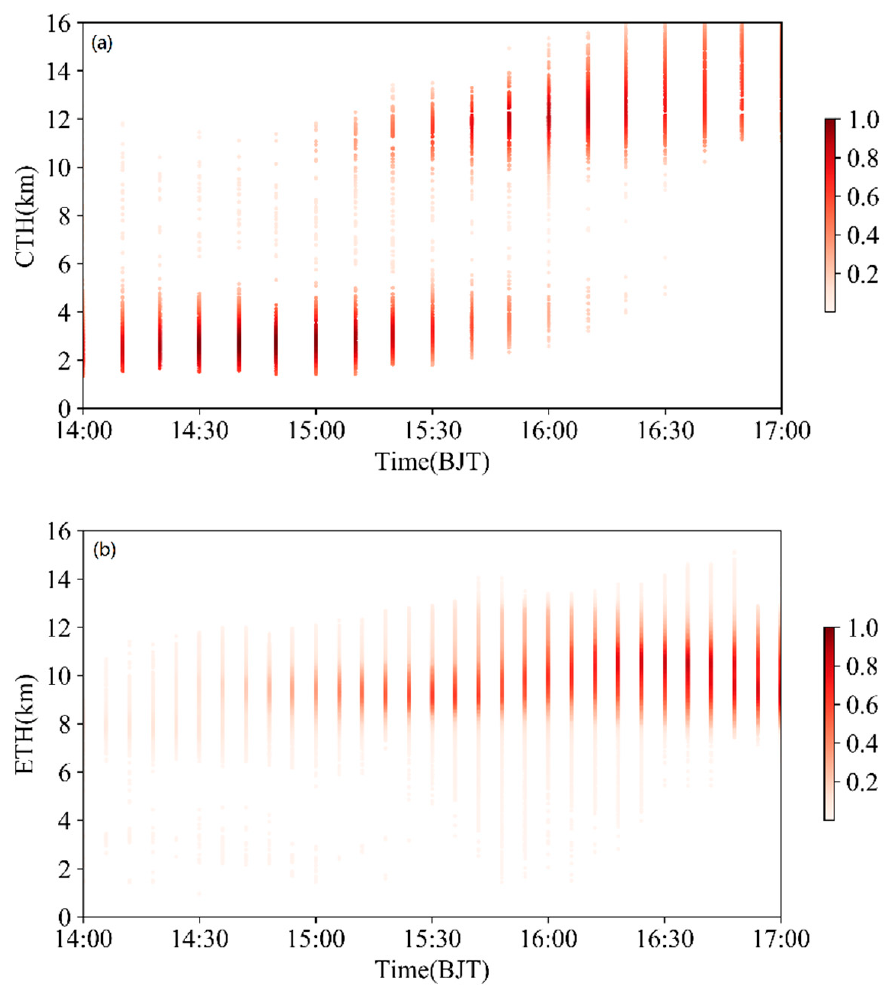
Figure 17. Cloud-top height (CTH) taken from the satellite and echo top height (ETH) from the weather radar as a function of observation time in the selected area between 116 ◦ E–117.5 ◦ E and 40 ◦ N–40.5 ◦ N on 1 July 2021; the color bar indicates the density of the image pixels in the observed data. ( a ) CTH from the Himawari-8 data. ( b ) ETH based on the composited weather radar.